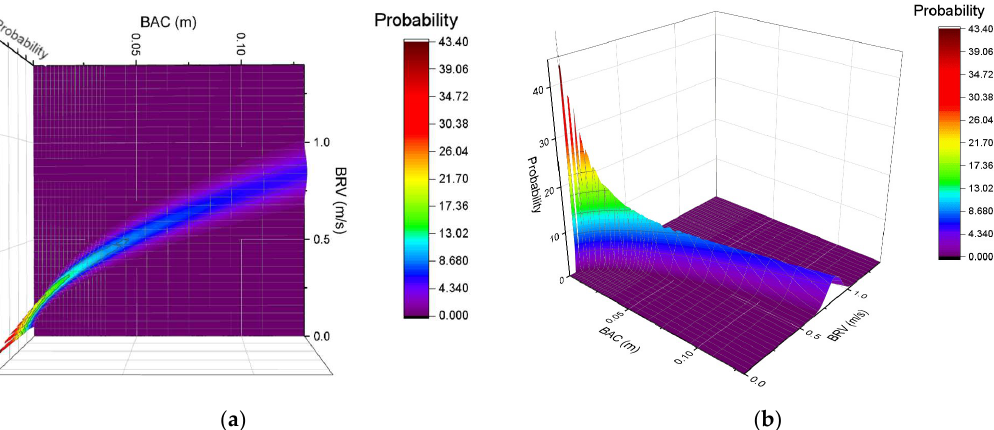
Figure 4. Probability density for the PPM for single bubbles injected at incipient fluidization conditions: ( a ) top view of the probability density plot; ( b ) isometric projection plot.